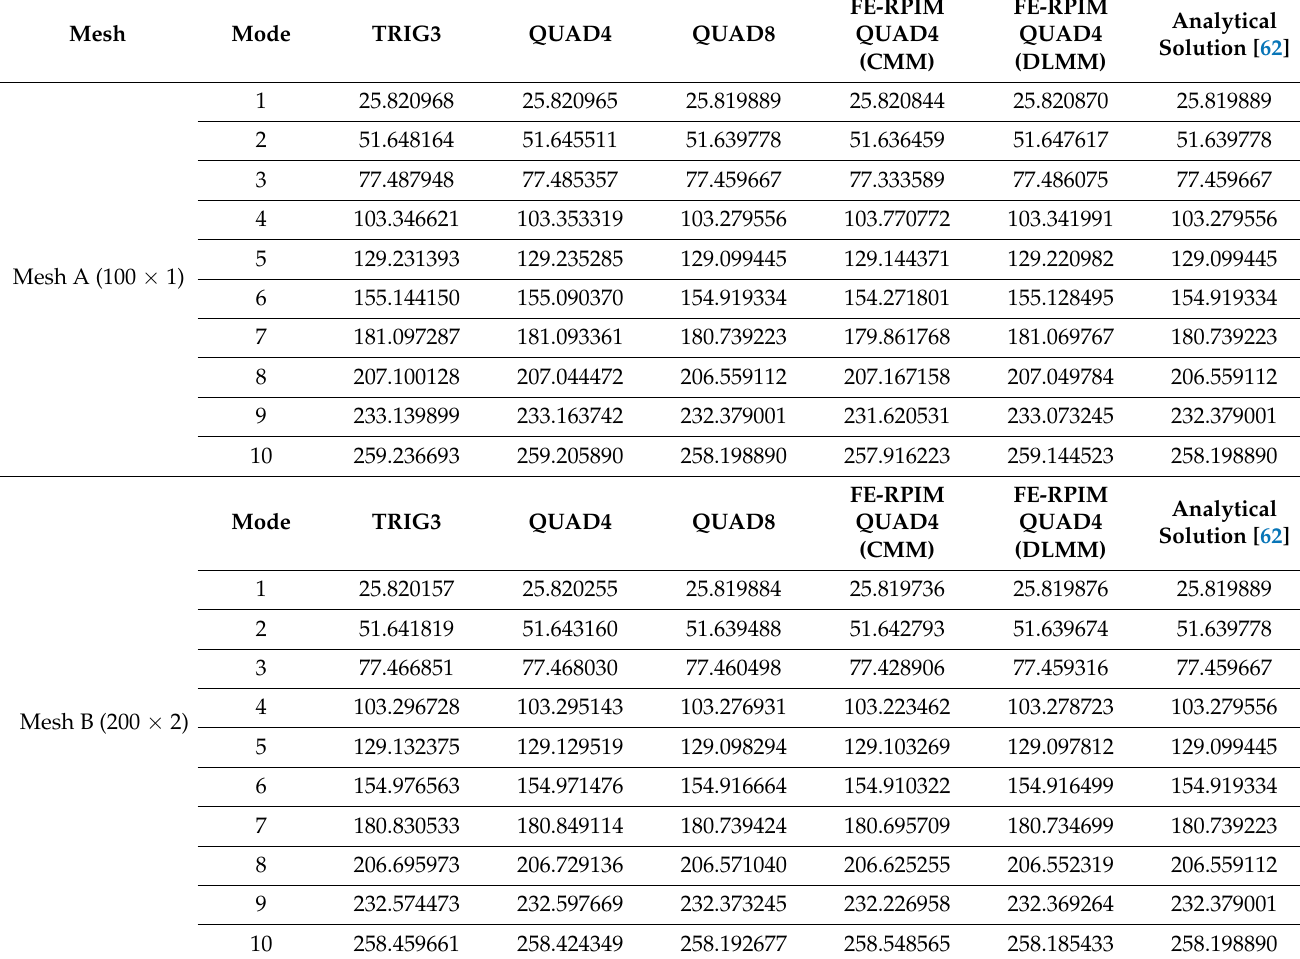
models. According to Table 1, the results from all the listed numerical models approach the analytical solution gradually, as the mesh density increases. Table 1. Comparisons of computed frequencies (Hz) for the slender rod with